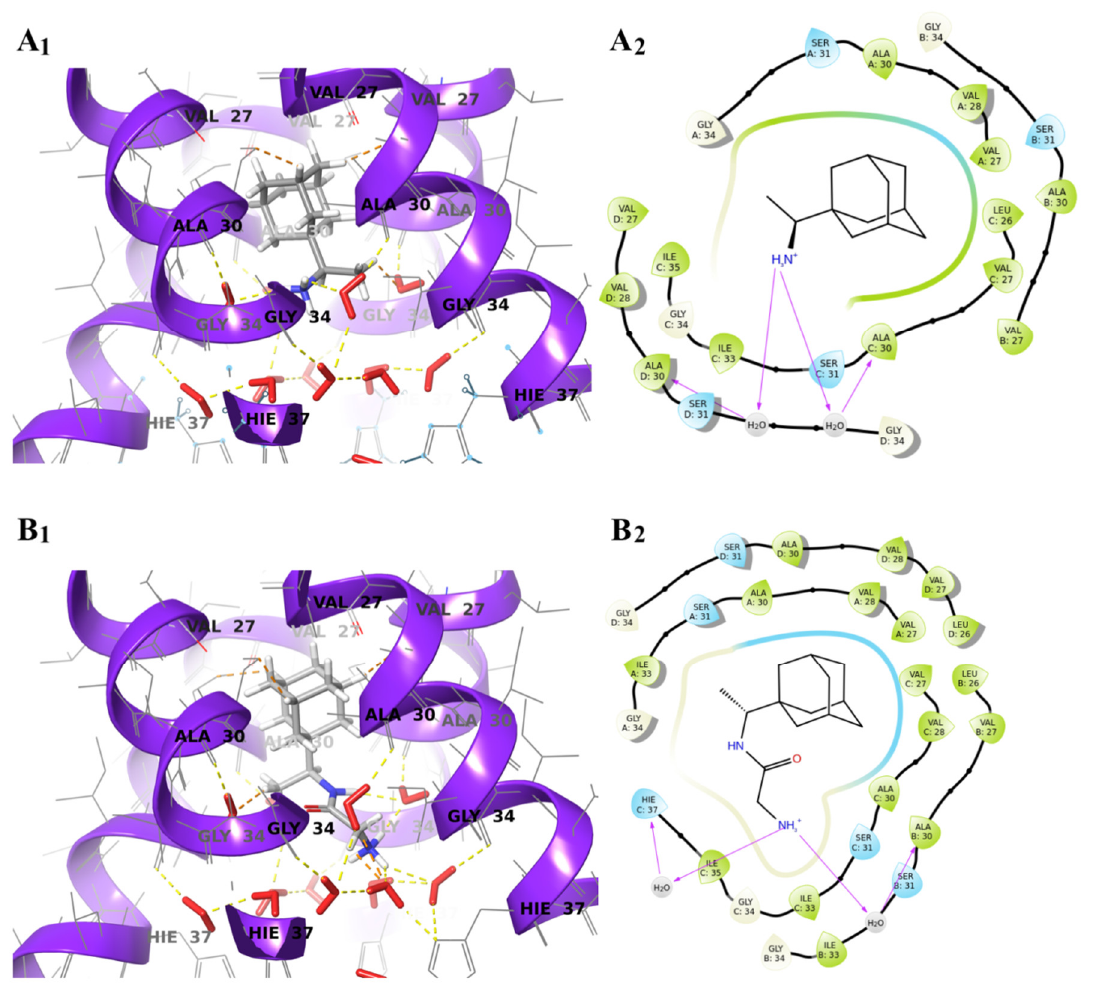
Figure 5. ( A1 ). The 3D docked pose of M2TM–rimantadine in the crystallized M2TM (PDB code: 6BOC) with the presence of water molecules (red color). Hydrogen bonds are depicted as yellow dashes. ( A2 ). The 2D docked pose of M2TM–rimantadine interactions within 5Å. ( B1 ). The 3D docked pose of M2TM–glycyl-rimantadine in the crystallized M2TM (PDB code: 6BOC) with the presence of water molecules (red color). Hydrogen bonds are depicted as yellow dashes. ( B2 ). The 2D docked pose of M2TM–glycyl-rimantadine interactions within 5Å.